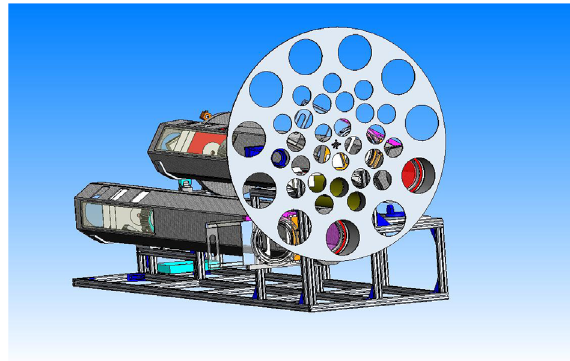
Fig. 7. C1 and C2 coronagraphs and their calibration wheel.